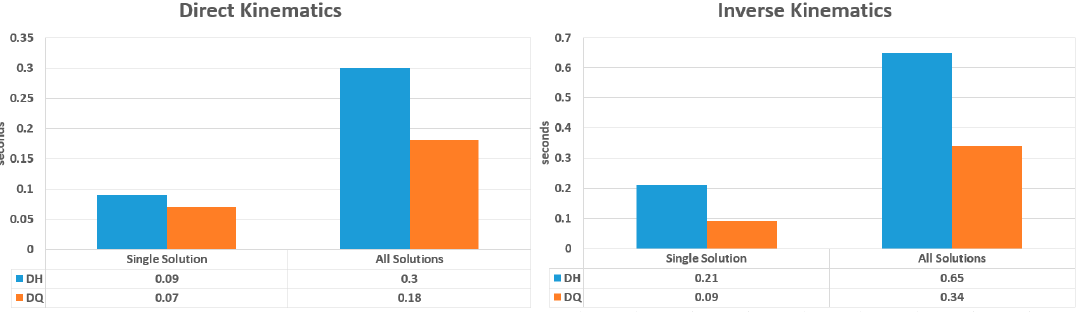
Figure 8. Computational time